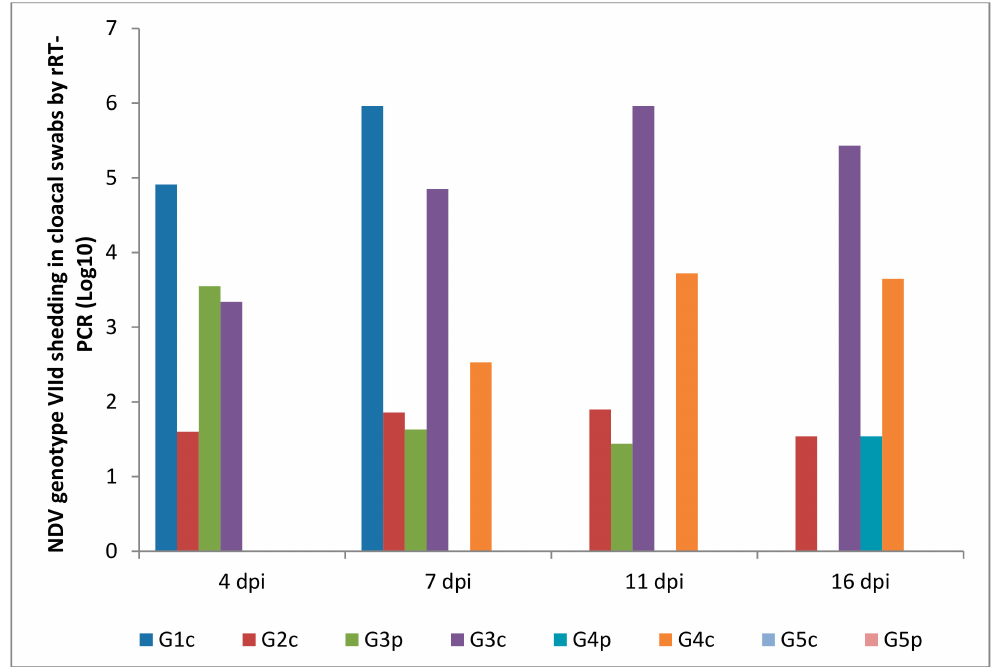
Figure 9. NDV genotype VIId oropharyngeal shedding by rRT-PCR (log 10 ). G1c: n = 10, G2c: n = 10, G3p: n = 15, G3c: n = 5, G4p: n = 15, G4c: n = 5, G5p: n = 10, and G5c: n =